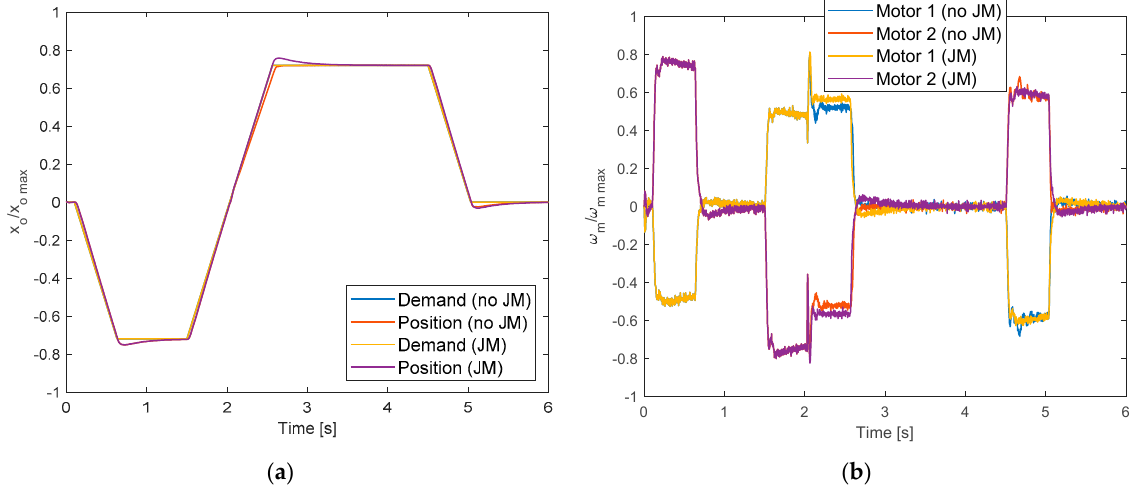
Figure 14. Jamming Monitor (JM) effect with block of screwshaft rotation (jamming of the internal screw-nut coupling) at 2.03 s (FDI latency = 90 ms); ( a ) output position; ( b ) motors speeds.